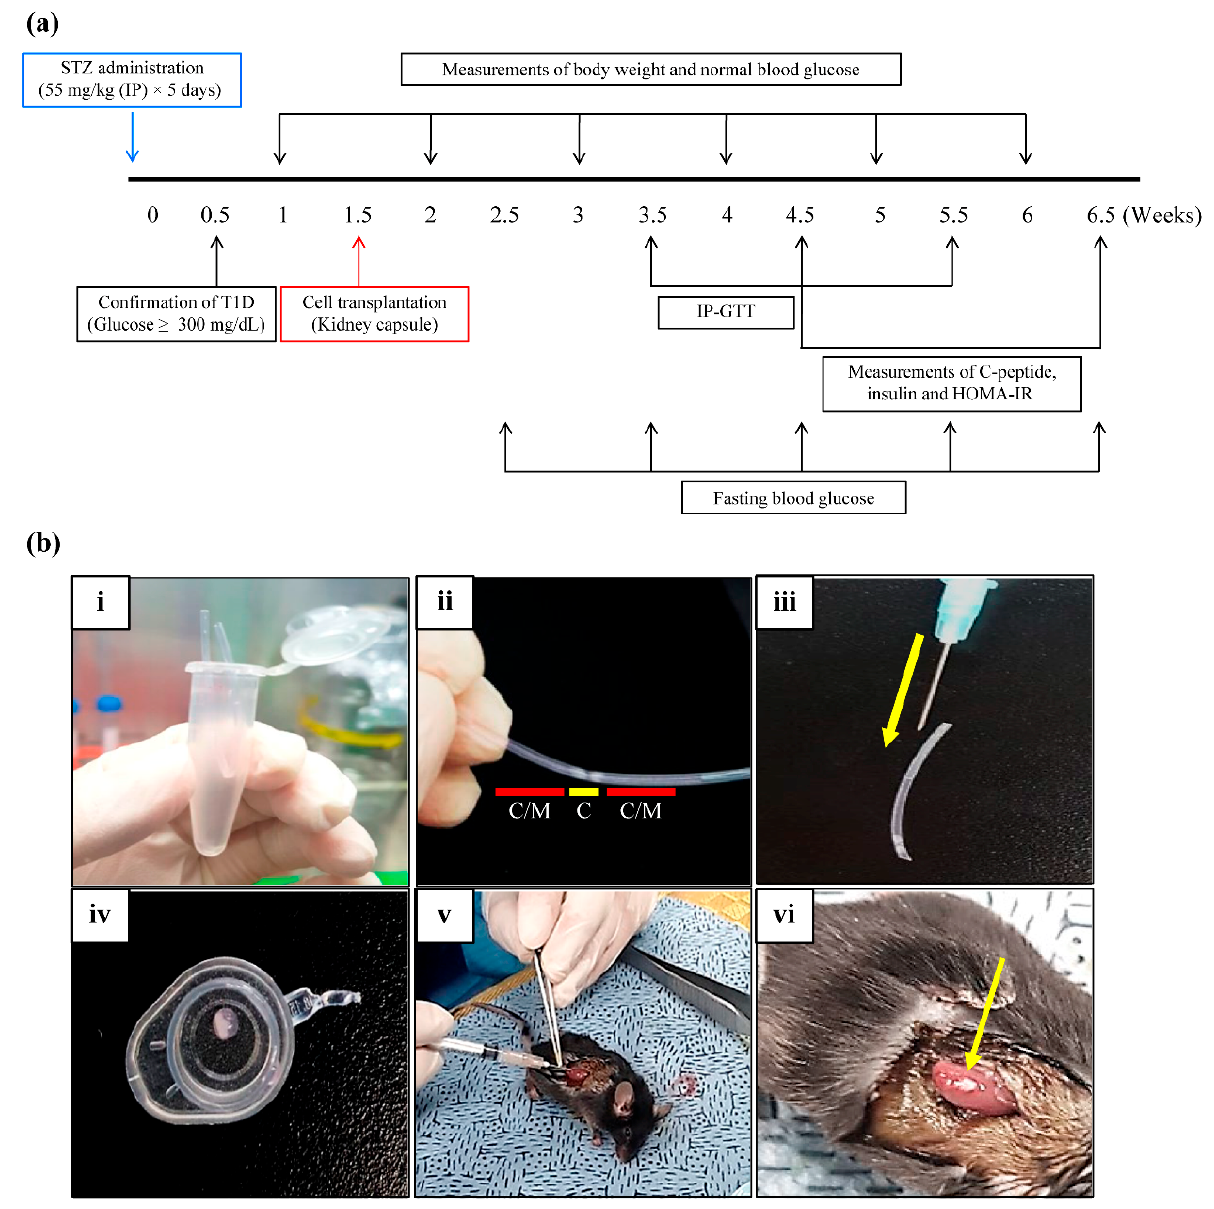
Figure 8. Establishment of the T1D mouse model, transplantation, and assessment. ( a ) After 3.5 and 5.5 weeks (2.5 and 4.5 weeks after cell transplantation, respectively), the animals were subjected to IP-GTT. At 4.5 and 6.5 weeks (3.5 and 5.5 weeks after cell transplantation, respectively), C-peptide and insulin levels were measured, and HOMA-IR was determined. Fasting blood glucose levels were measured weekly from 2.5 to 6.5 weeks. Body weight and normal blood glucose were measured weekly from week 1 to 6. At 2.5 and 6.5 weeks (3.5 and 5.5 weeks of cell transplantation, respectively), C-peptide and insulin levels were measured, and HOMA-IR was determined. At 6.5 weeks, the animals were sacrificed for analyses. ( b ) Cell suspension transplantation under kidney capsule.